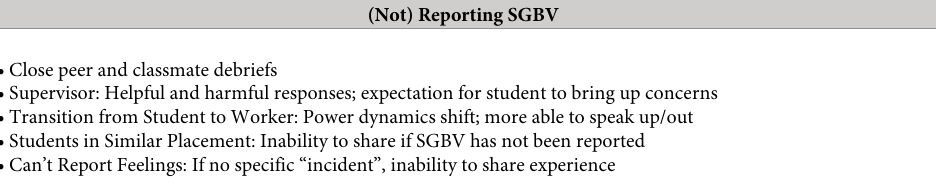
Table 3. Influential structure on women’s decision of whether to (not) report